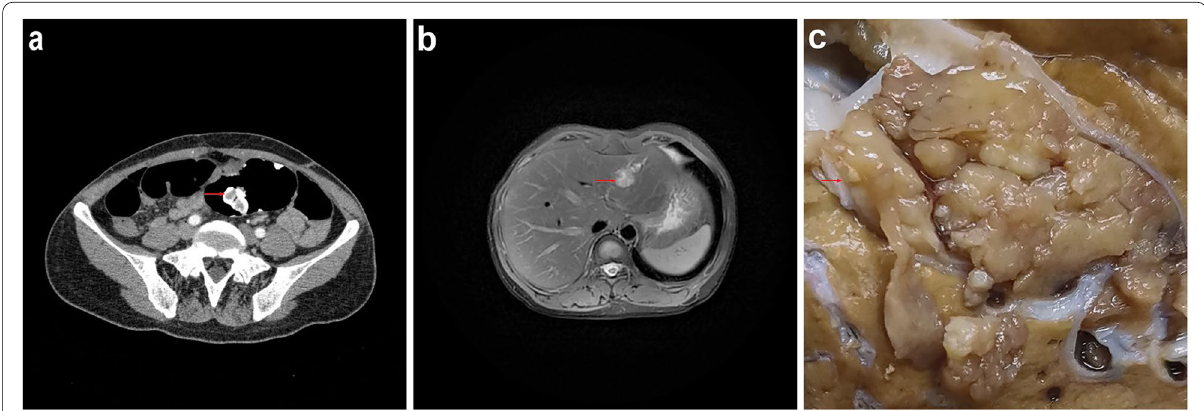
Fig. 1 Pelvic CT and Abdominal MRI from the case and gross features of the neoplasm. a Pelvic CT showed nodular soft tissue shadow in the intestinal lumen of sigmoid colon, surrounded by high-density contrast agent. Red arrow indicates designate polyps. b Abdominal MRI showed a round low-density mass in the left lobe of liver with a clear border. Red arrow indicates designate IOPN. c Macroscopically, the neoplasm had a clear boundary with the surrounding liver tissue. Red arrow indicates designate